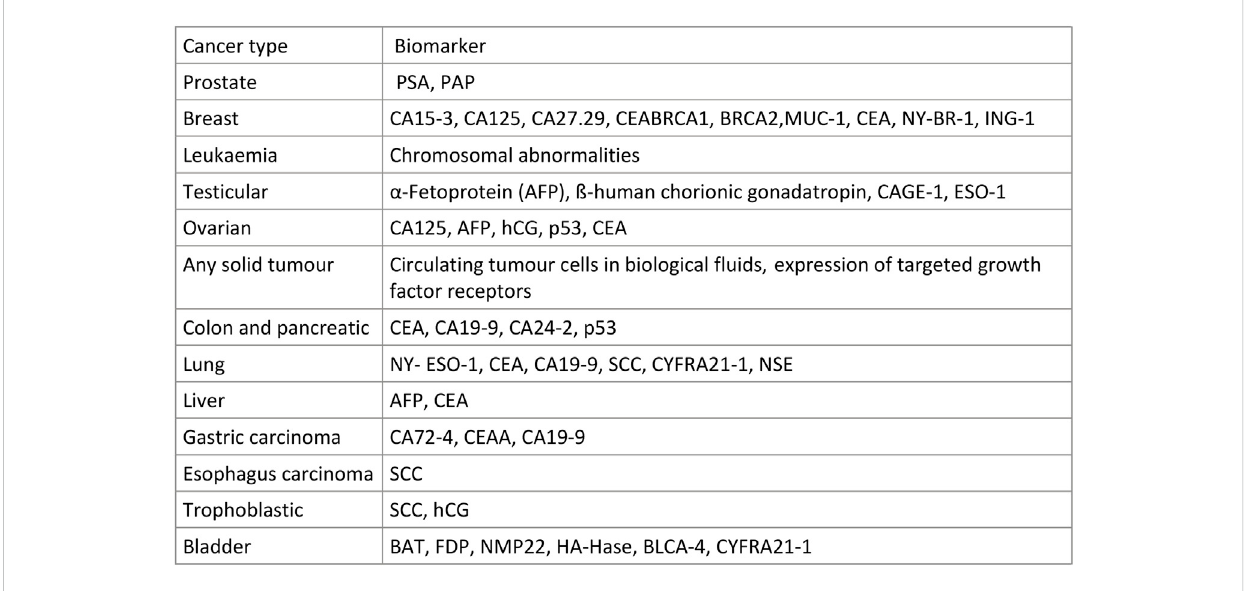
Some common Tumor